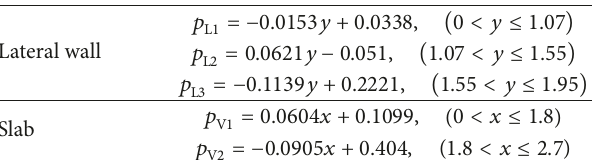
Table 6: Fitting of the earth pressure ( h =8